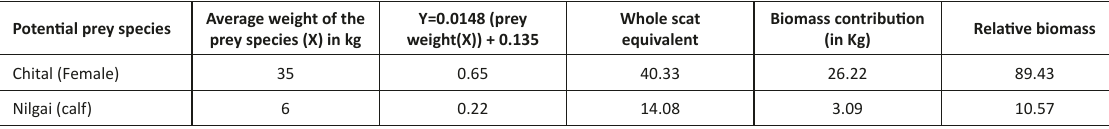
Table 2. Relative biomass of the major jackal prey as calculated by the regression equation of Jethva & Jhala (2004). Average weight of the Potential prey species prey species (X) in